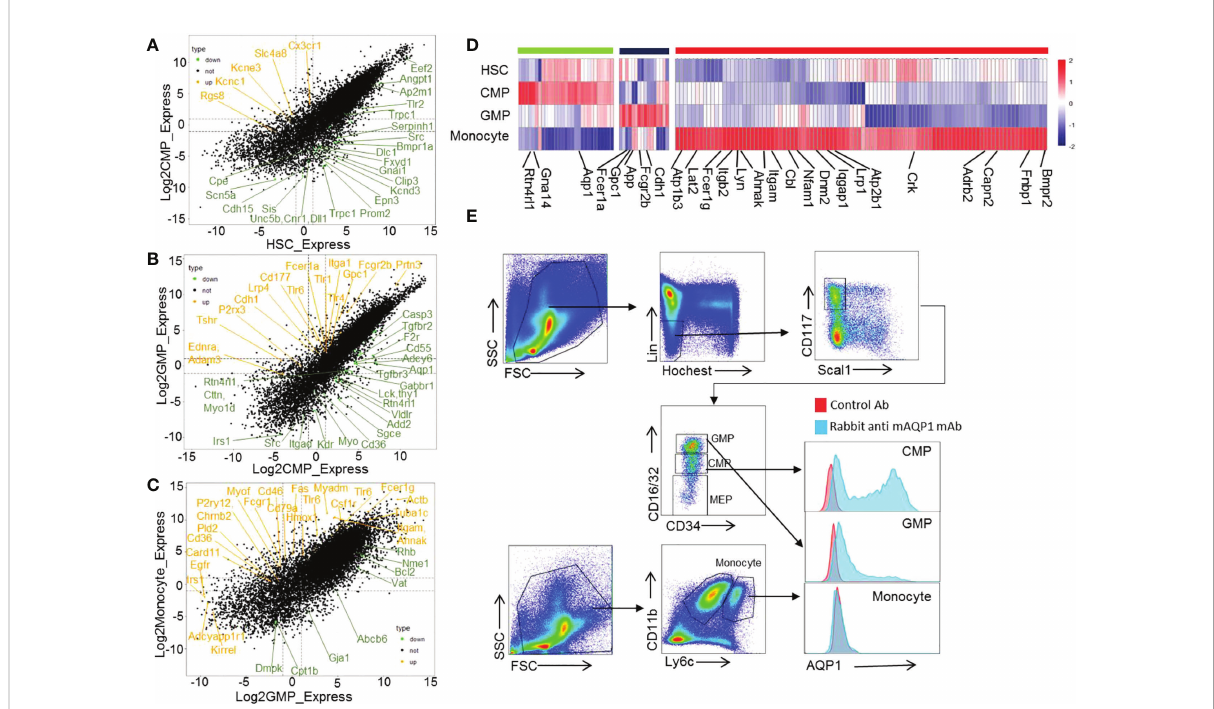
FIGURE 3 Cell membrane proteins selectively expressed in certain stage during mouse HSC differentiation to monocytes development. The dot plot showing the modulated genes between HSC – >CMP (A) , CMP – >GMP (B) , and GMP – >monocyte (C) during mouse monocyte development. The orange color represents the upregulated membrane-related genes, and the green color represents the downregulated membrane-related genes. (D) Heatmap displaying the selectively upregulated membrane-related genes in mouse HSCs, CMPs, GMPs, and monocytes. (E) The expression of AQP1 protein on mouse CMPs, GMPs and monocytes as detected by fl ow